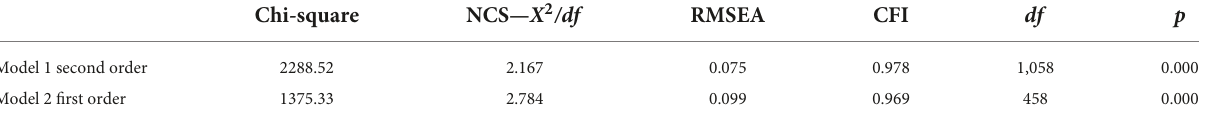
TABLE 6 Goodness of fit